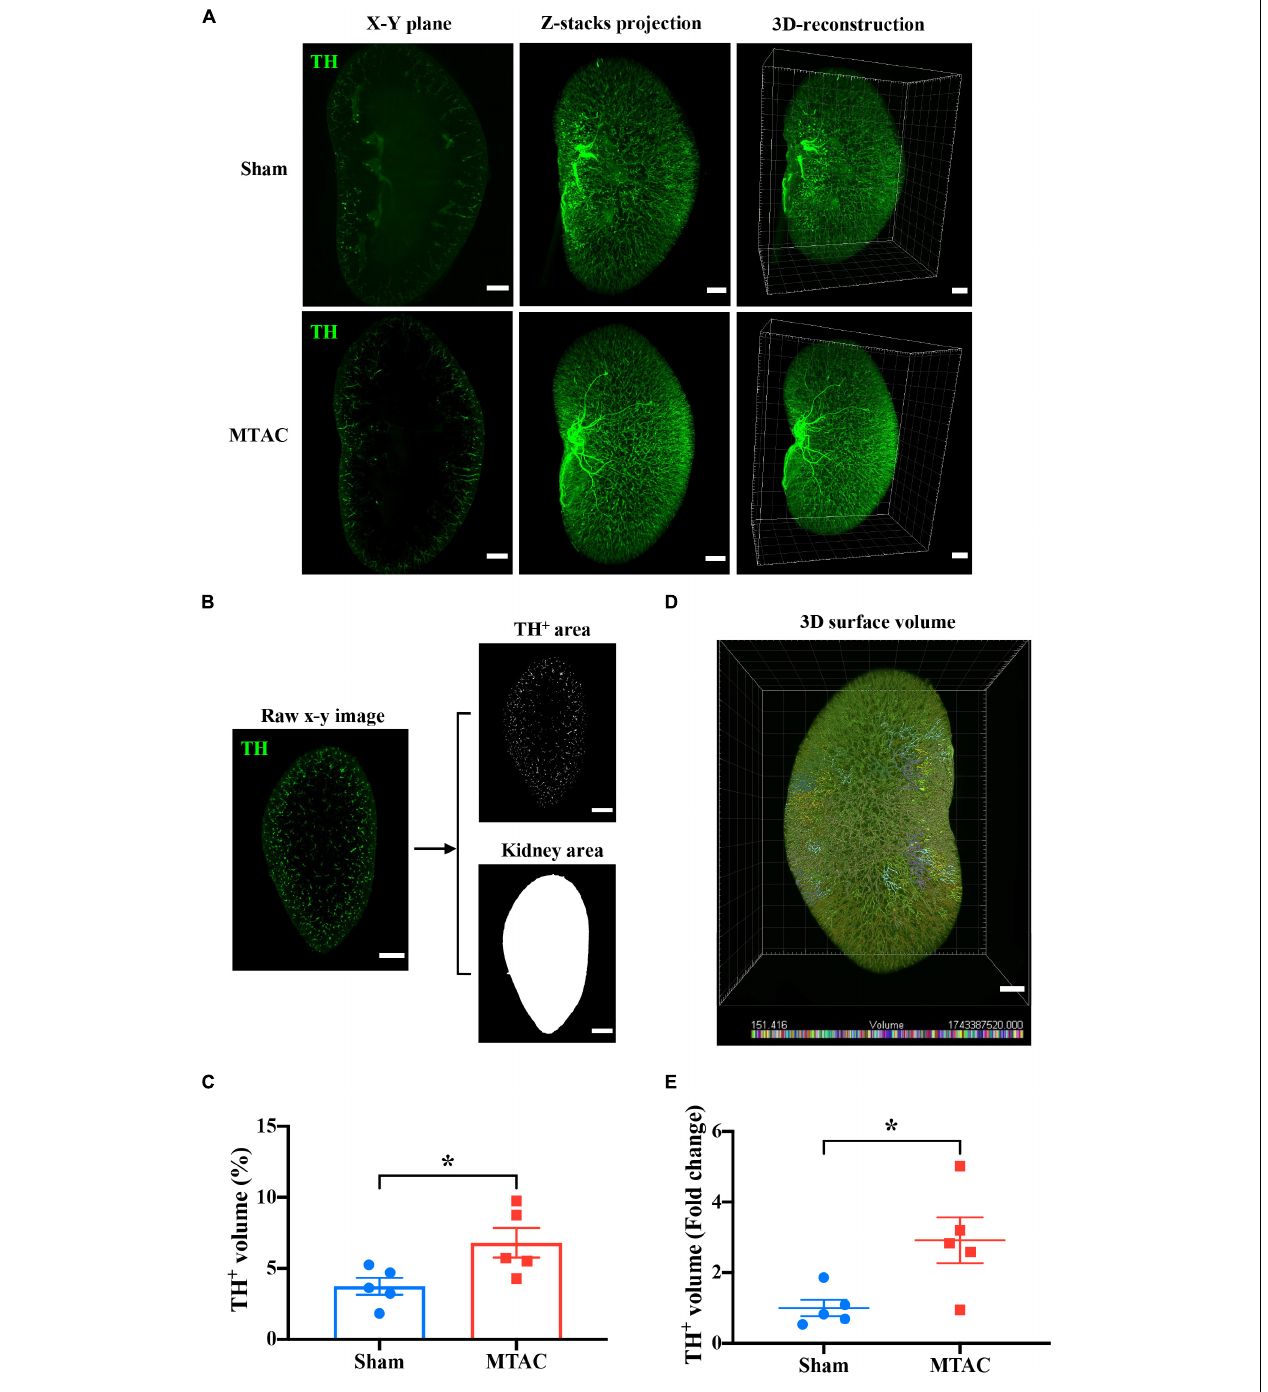
FIGURE 6 | Whole-kidney 3D analysis reveals renal sympathetic hyperinnervation. (A) Comparison of sympathetic nerve (TH) innervation in the X – Y plane, z-stack projection, and 3D construction between the sham group (z-stack of 1258 slices) and MTAC group (z-stack of 1142 stacks). Scale bar = 1 mm. (B) The process of calculating the ratio of the TH-positive volume to the total kidney volume is shown. After appropriate threshold binary conversion, the integral area of interest was calculated. Z-step = 5 µ m. (C) The 3D analysis showed that the sympathetic nerve volume/total kidney volume ratio significantly increased in the MTAC group compared with the sham group ( n = 5 mice per group). To increase the accuracy of the calculation and for convenience, a 3D surface volume computation protocol (D) was introduced. The bottom of the image shows the volume labeled by distinct colors. (E) Quantification analysis with real 3D analysis after the 3D surface protocol showed that the TH-positive volume/total kidney volume ratio fold change significantly increased in the MTAC group compared with the sham group ( n = 5 mice per group). TH, tyrosine hydroxylase. Sympathetic nerves were labeled with anti-TH antibody (green). * P < 0.05.